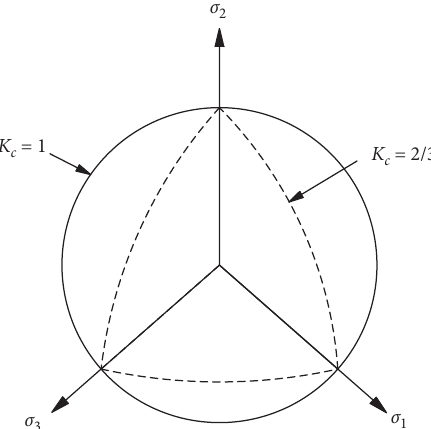
Figure 11: Projection of yield surface on the deviatoric plane.